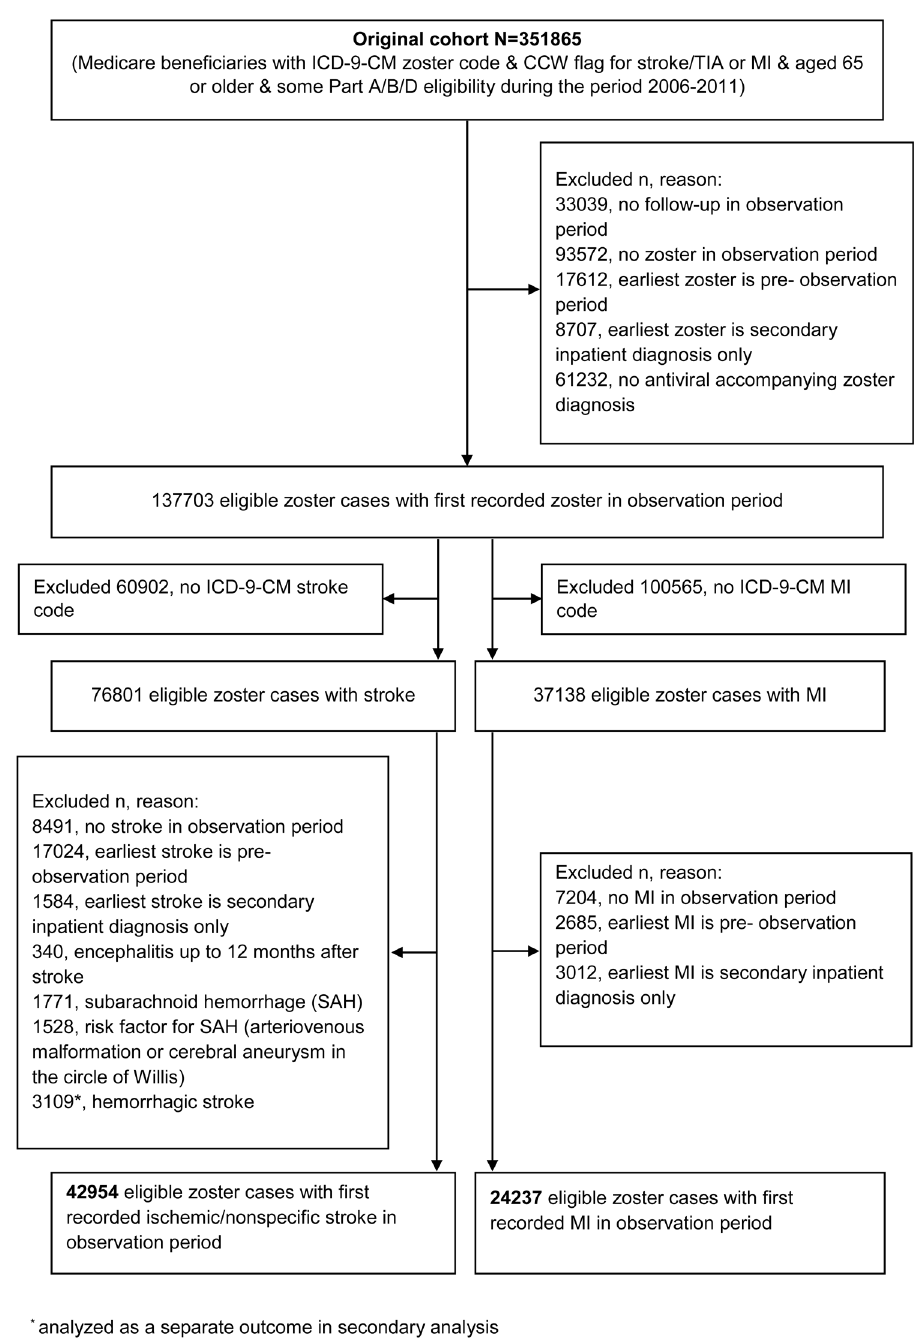
Fig 2. Identification of study participants. CCW, Chronic Conditions Data Warehouse; TIA, transient ischemic attack.